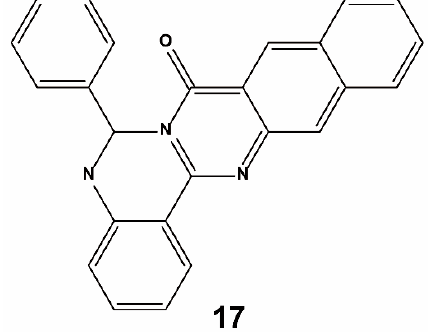
Figure 11. Structure of compound 17 .